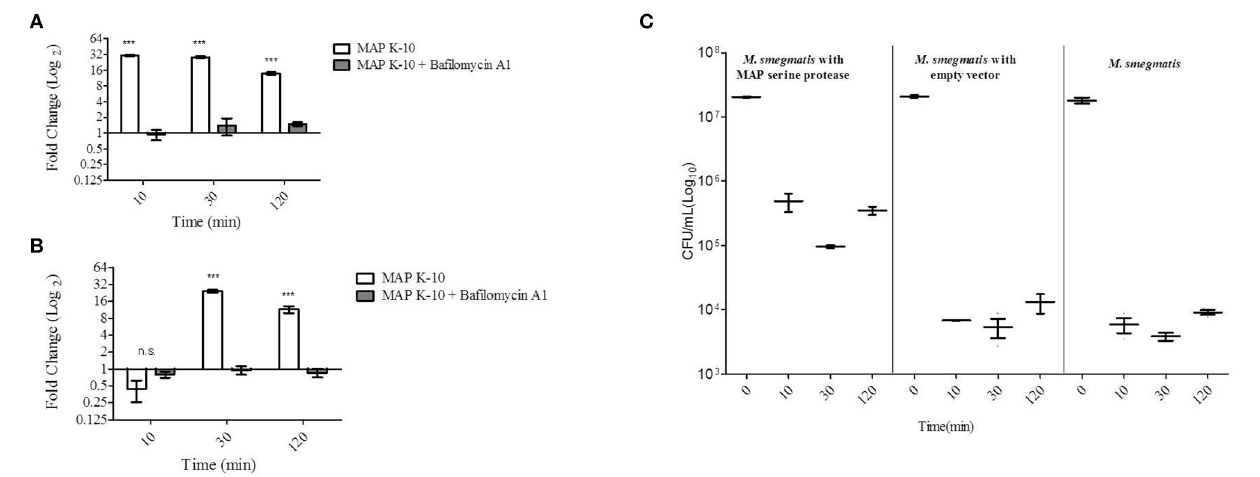
FIGURE 2 | MAP0403 is expressed in MDMs and MAC-T cells and correlates with M. smegmatis survival during infection. MAP0403 expression was analyzed by qT-RT-PCR in (A) MDMs and (B) MAC-T cells at 10, 30, and 120 min post MAP K-10 infection. MAP0403 is up-regulated within 10 min post-infection but decreases by 14-fold at 120 min in MDMs. MAP0403 expression peaks at 30 min post-infection in MAC-T cells. Similar to MDMs, MAP0403 expression decreases at 120 min in MAC-T cells. Bafilomcyin A1 pre-treatment of MDMs and MAC-T cells decreased or abolished MAP0403 expression. (C) M. smegmatis mc 2 155 parent, MAP0403 expression strain (pSM417- MAP0403 ), and vector control [pSM417 (empty)] were allowed to invade MDMs for 10, 30, and 120 min and subsequently assessed for bacterial viability by direct plating. M. smegmatis mc 2 155 expressing MAP0403 cells had higher rates of recovery compared to parent and vector control strains. *** P < 0.001, n.s. not